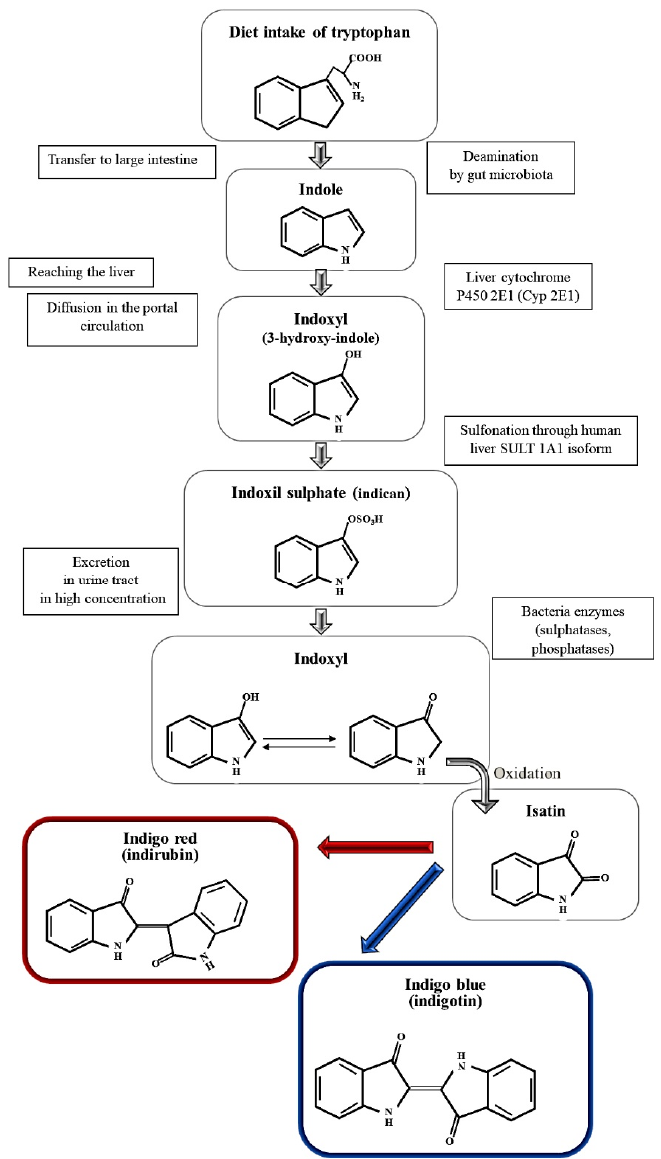
Figure 3. Metabolic steps of tryptophan (TRP). In the presence of bacterial enzymes such as sulphatases and phosphatases, indican forms two isomeric metabolites: indigo blue (indigotin) and indigo red (indirubin). These metabolites dissolve in or deposit on the surface of urine bag material and are responsible for its blue/purple coloring according to the indigotin/indirubin ratio due to oxidative conditions and the pH value of the urine [33–35]. We found in the patient’s urine both Gram+ and Gram − bacteria, which produce several types of enzymes, including sulpha- tases, phosphatases, catalase, and oxidase, capable of sticking to the urine bag surface, and growing and building a matrix to form a community named “biofilm” [36]. The image obtained under SEM showed that the urine bag had a wrinkled and rough surface, so we hypothesized the presence of microbial biofilm [37], which can be responsible for the var- iation of element values, perhaps because it represents an obstacle to correct scanning of the urine bag’s surface.